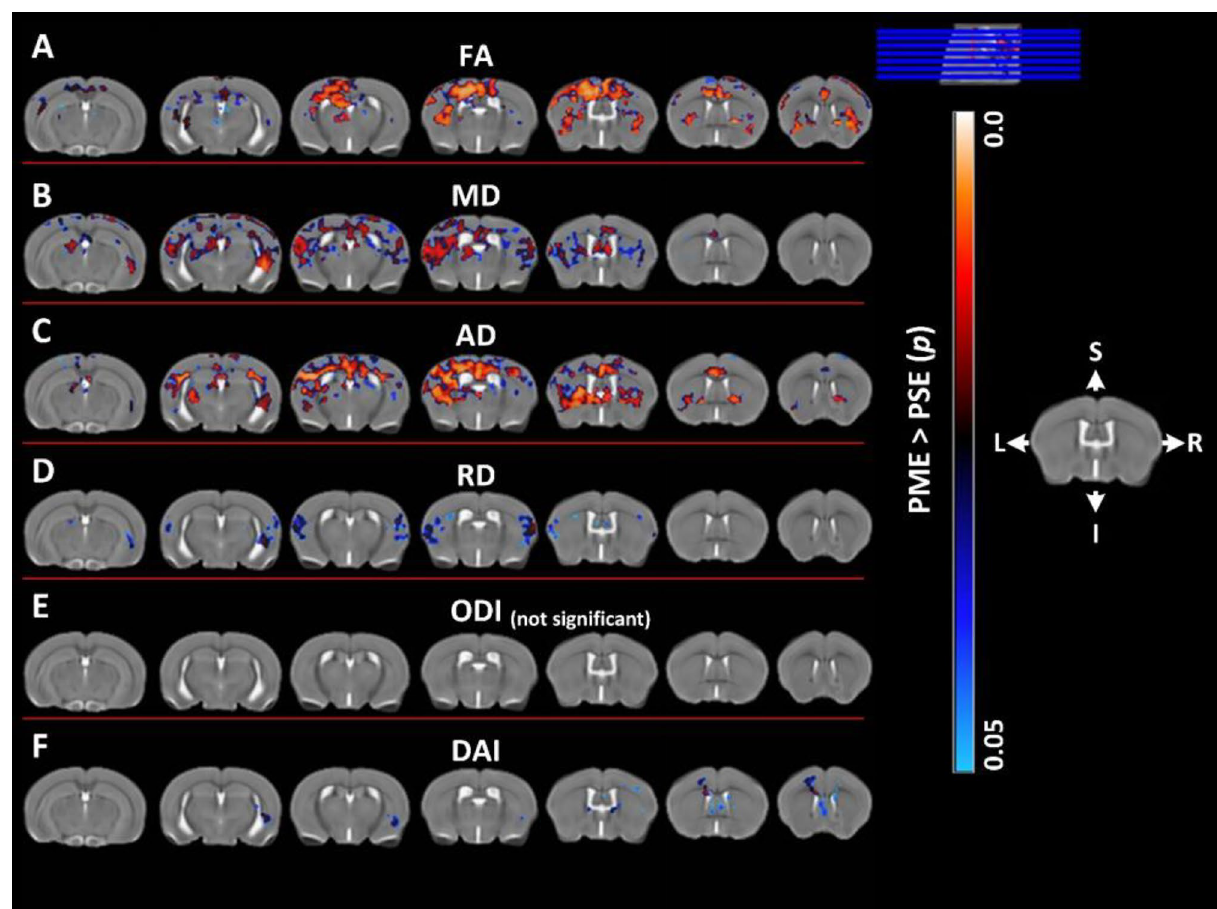
Figure 3. Voxel-wise statistical maps using DTI and NODDI derived parametric maps. Clusters depicted in false color indicate regions where PME (n = 15) animals exhibited significantly higher values compared to PSE (n = 15). The results were family-wise error corrected for multiple comparisons ( p < 0.05). Variation in color maps highlight the degree of significance. The results are overlayed on a study specific B0 template for better visualization. FA: fractional anisotropy, MD: mean diffusivity, AD: axial diffusivity, RD: radial diffusivity, ODI: orientation dispersion index and DAI, dispersion anisotropy index. L and R indicate anatomical orientation: Left–Right. S and I indicate anatomical orientation: